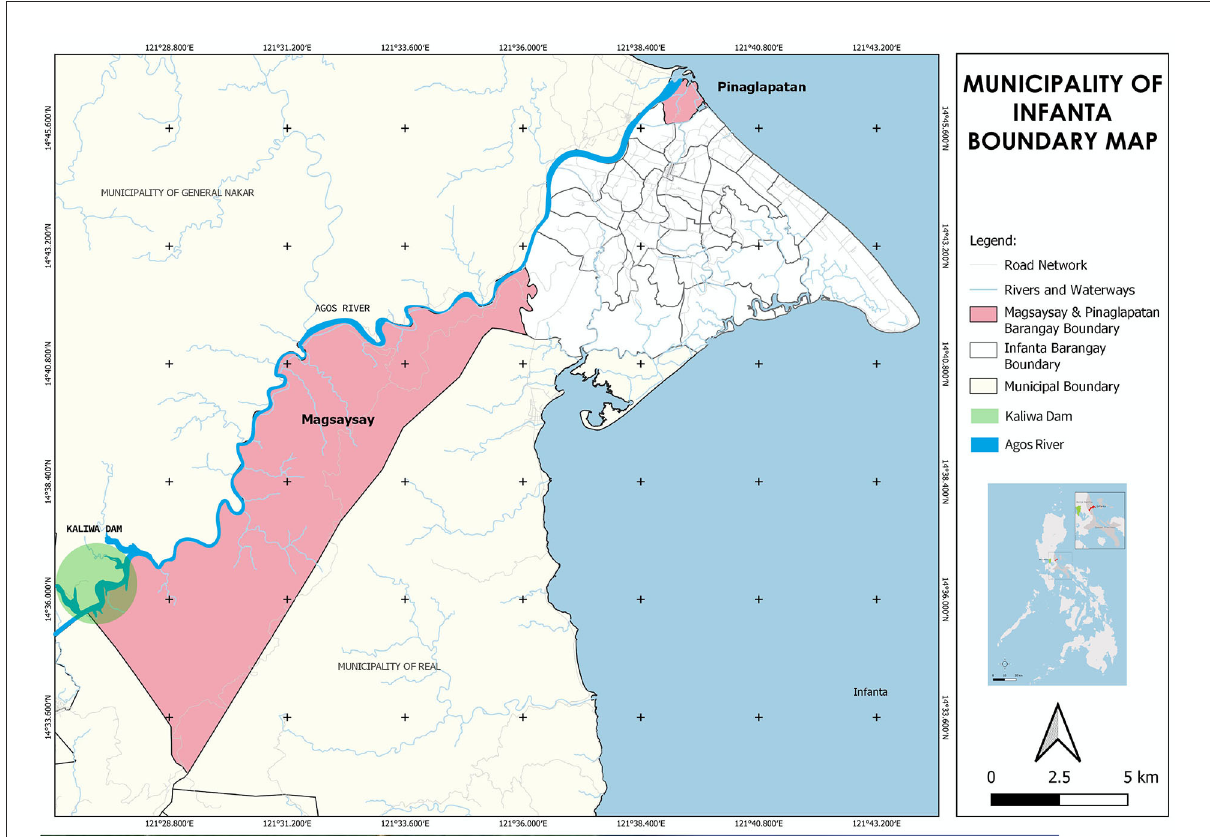
FIGURE1 Location map showing barangays Pinaglapatan and Magsaysay and the site of the Kaliwa Dam reservoir in the municipality of Infanta, Province of Quezon in the Philippines. The location of Metro Manila relative to Infanta is also shown in the inset in the right bottom corner. Source: Data from National Mapping and Resource Information Authority